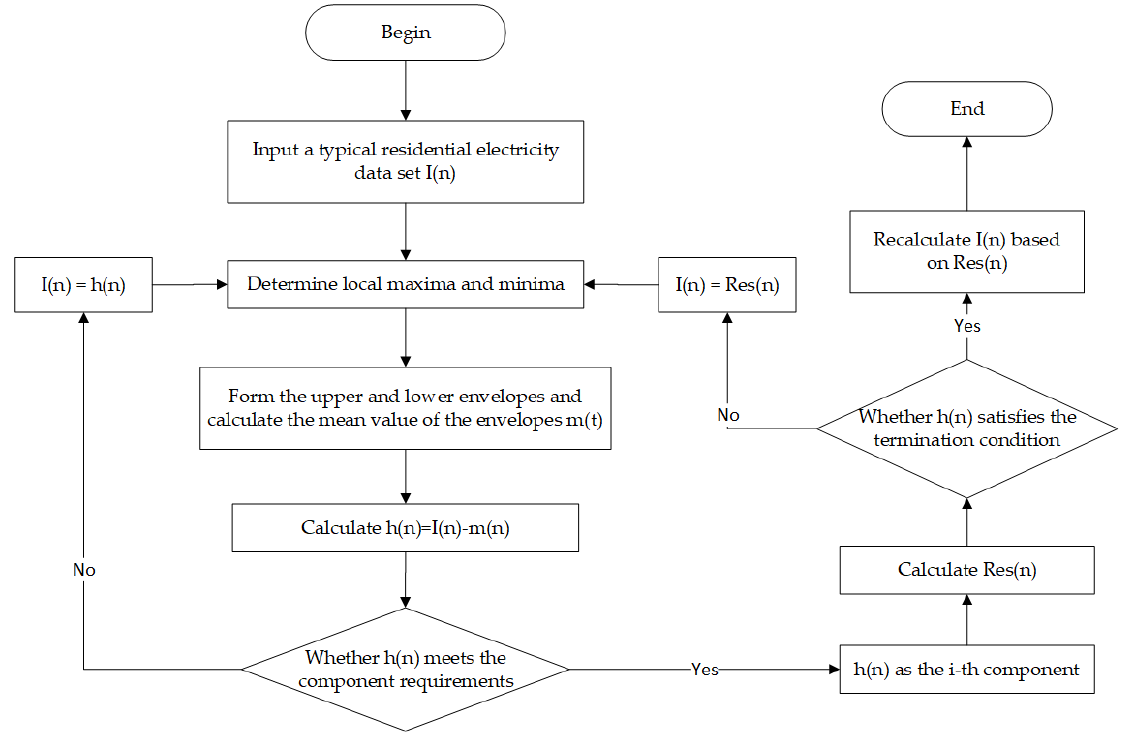
Figure 2. The structure of the EMD.